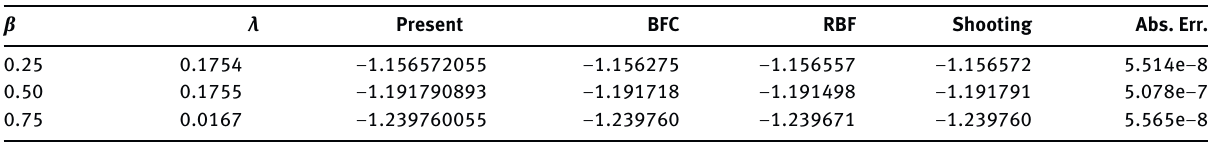
Table 1: Comparison of the obtained values of y ′ (0) for β = 0.25, 0.50, 0.75 by the present method, Shooting method[24], BFC [20], and RBF [24], with m = 35 and α = 0.50